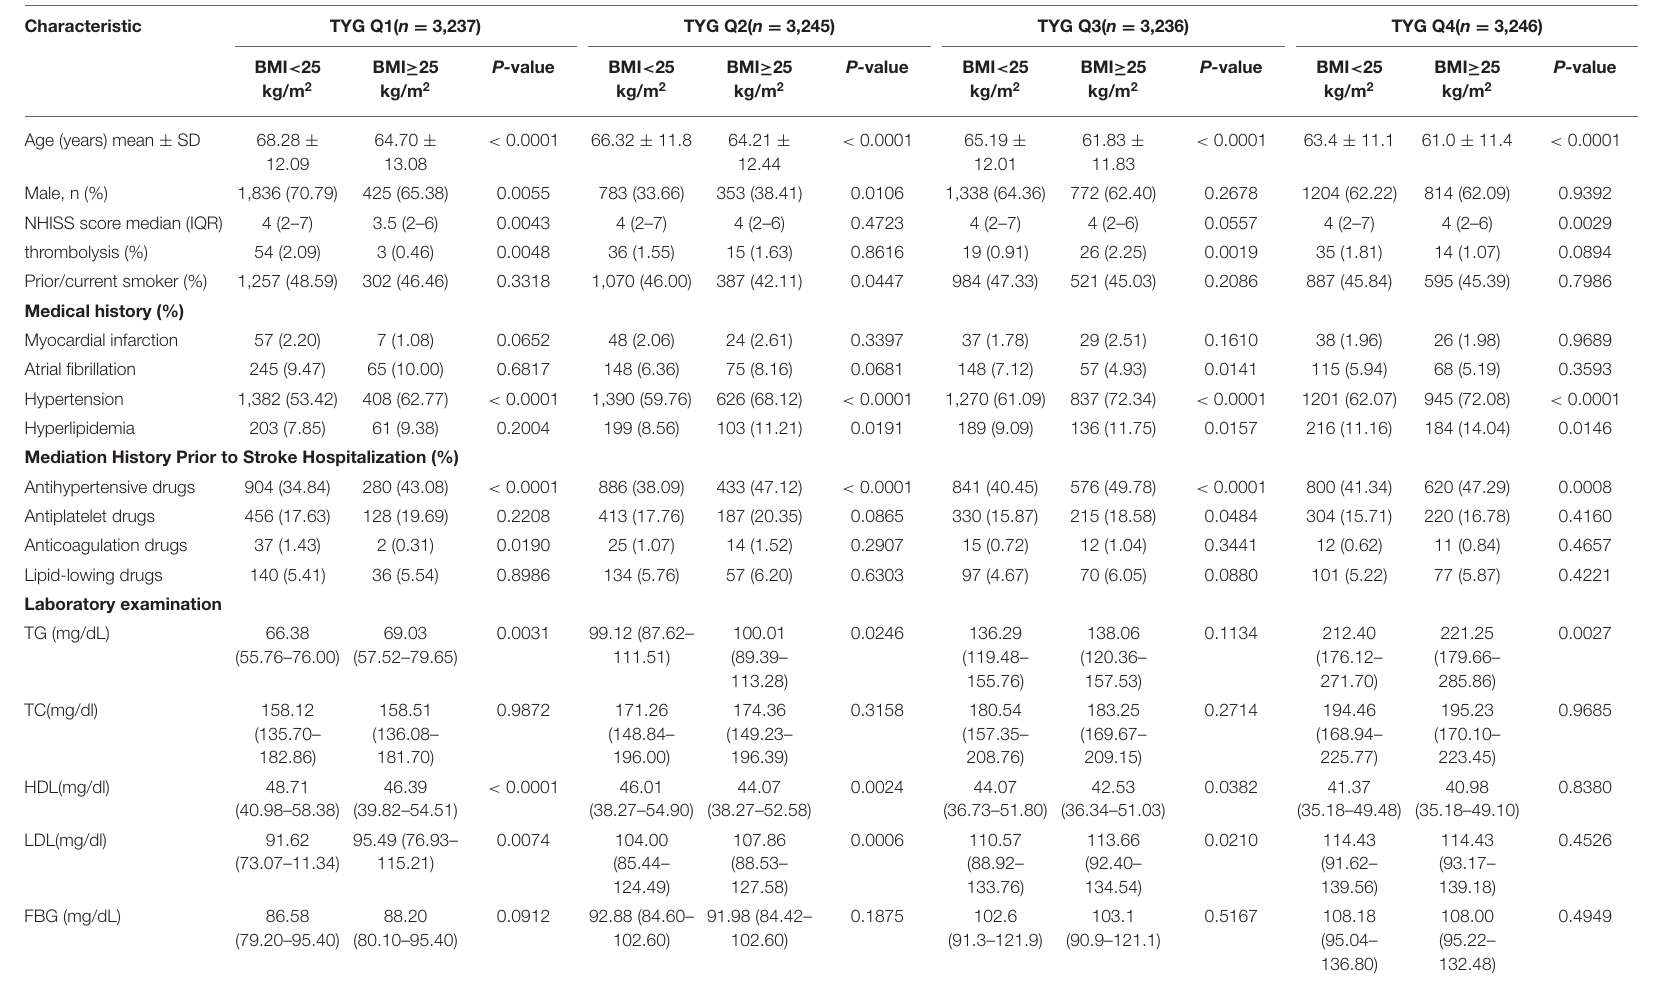
TABLE 1 | Baseline characteristics of patients stratified by TYG index and BMI